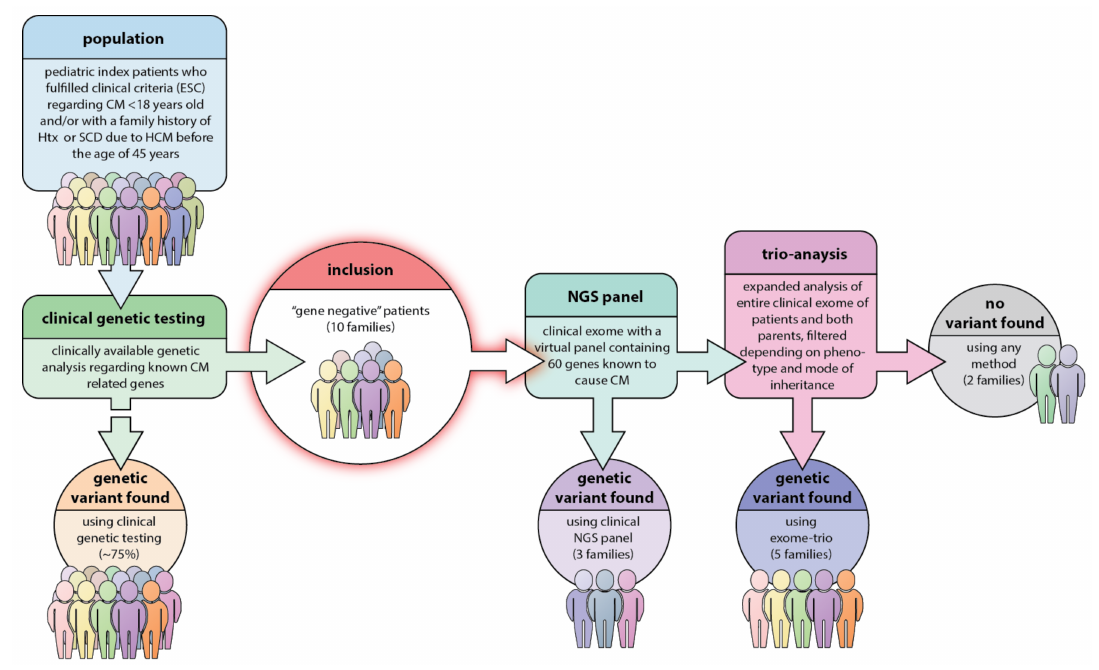
Figure 1. Study design and work-flow in our study. In the original young hypertrophic cardiomyopathy (HCM)-population, nearly 75% were found to carry a previous known HCM-causative genetic